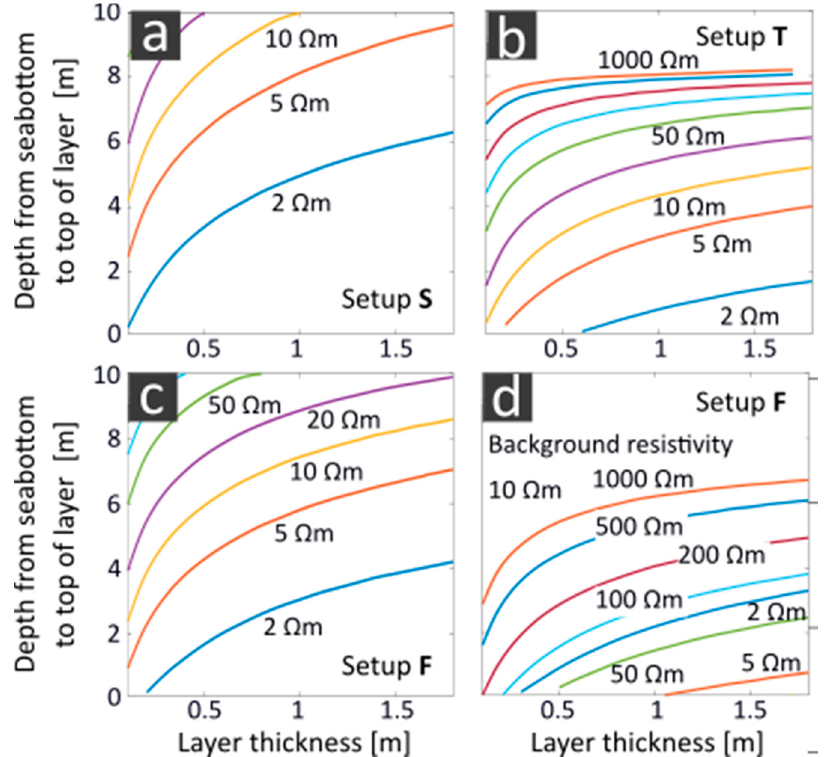
Figure 12. Plot of the maximum depth to which a layer of variable thickness and resistivity can be differentiated from the surrounding sea bottom. The depth is defined as the distance between the sea di ff erentiated from the surrounding sea bottom. The depth is defined as the distance between the sea floor for a brackish water column of 1 m to the upper edge of the layer. The sea bottom shows floor for a brackish water column of 1 m to the upper edge of the layer. The sea bottom shows resistivity resistivity values of ( a – c ) 1 Ω m and ( d ) 10 Ω m. The measurement uncertainties of setup ( a ) S values of ( a – c ) 1 Ω m and ( d ) 10 Ω m. The measurement uncertainties of setup ( a ) S (submerged), ( c , d ) F (submerged), ( c , d ) F (floating) and ( b ) T (towed) are compared. (floating) and ( b ) T (towed) are